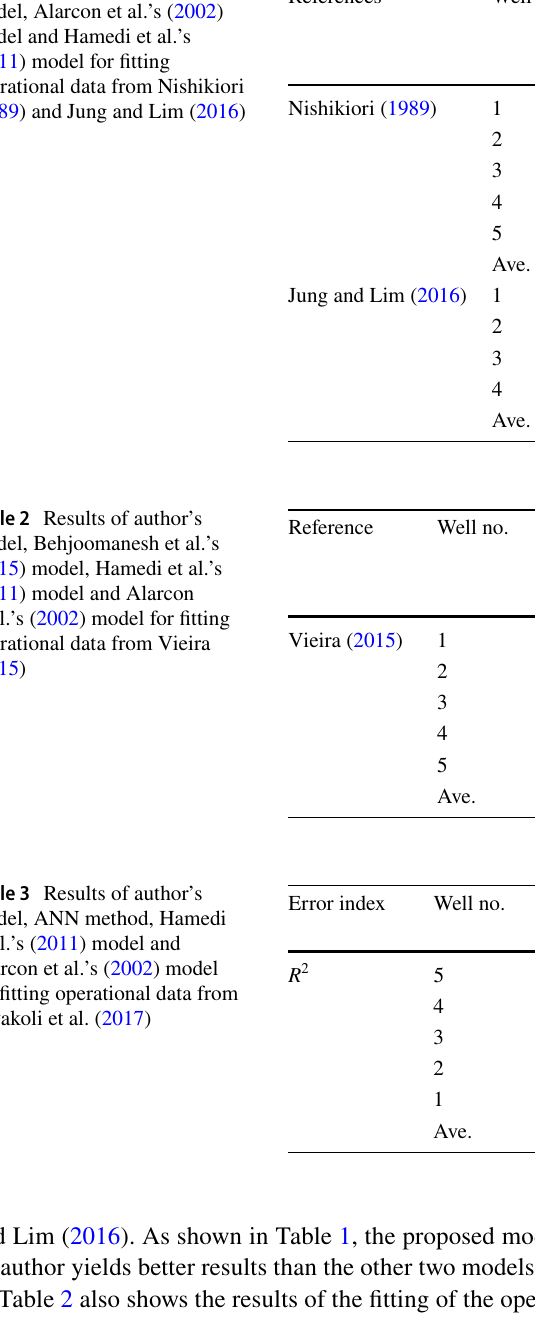
Table 1 Results of author’s model, Alarcon et al.’s (2002) model and Hamedi et al.’s (2011) model for fitting operational data from Nishikiori (1989) and Jung and Lim (2016)